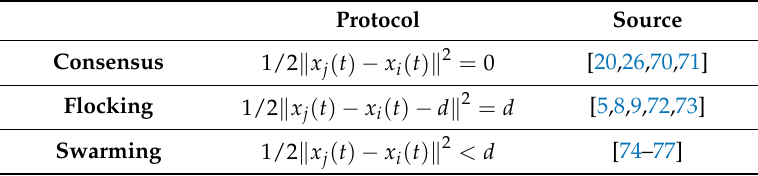
Table 2. Different Coordination Protocols.